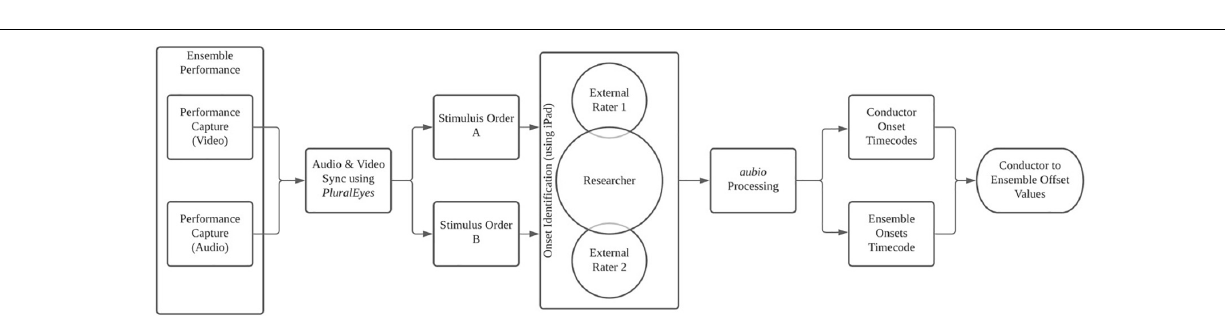
FIGURE 2 | Diagram of audio and video onset processing from capture to offset